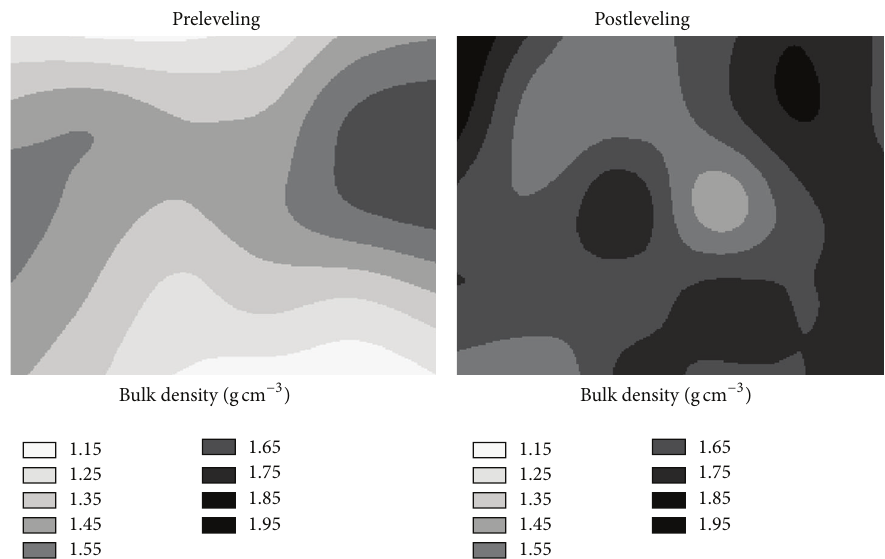
Figure 3: Pre- and post-leveling spatial distributions of soil bulk density for surface soil (0–20cm).